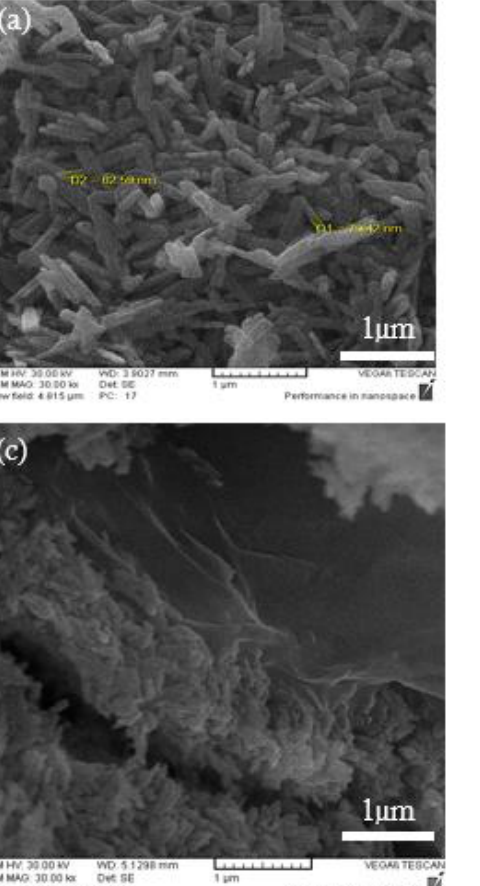
, (b) CdWO -RGO140, (c) CdWO 4 4